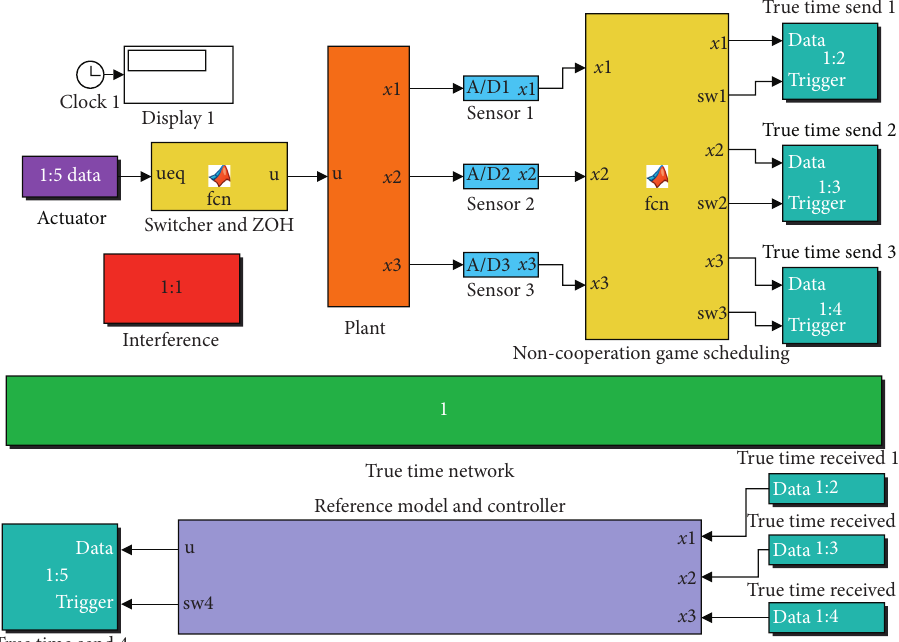
Figure 5: True time simulation platform of HOSMC with noncooperative game